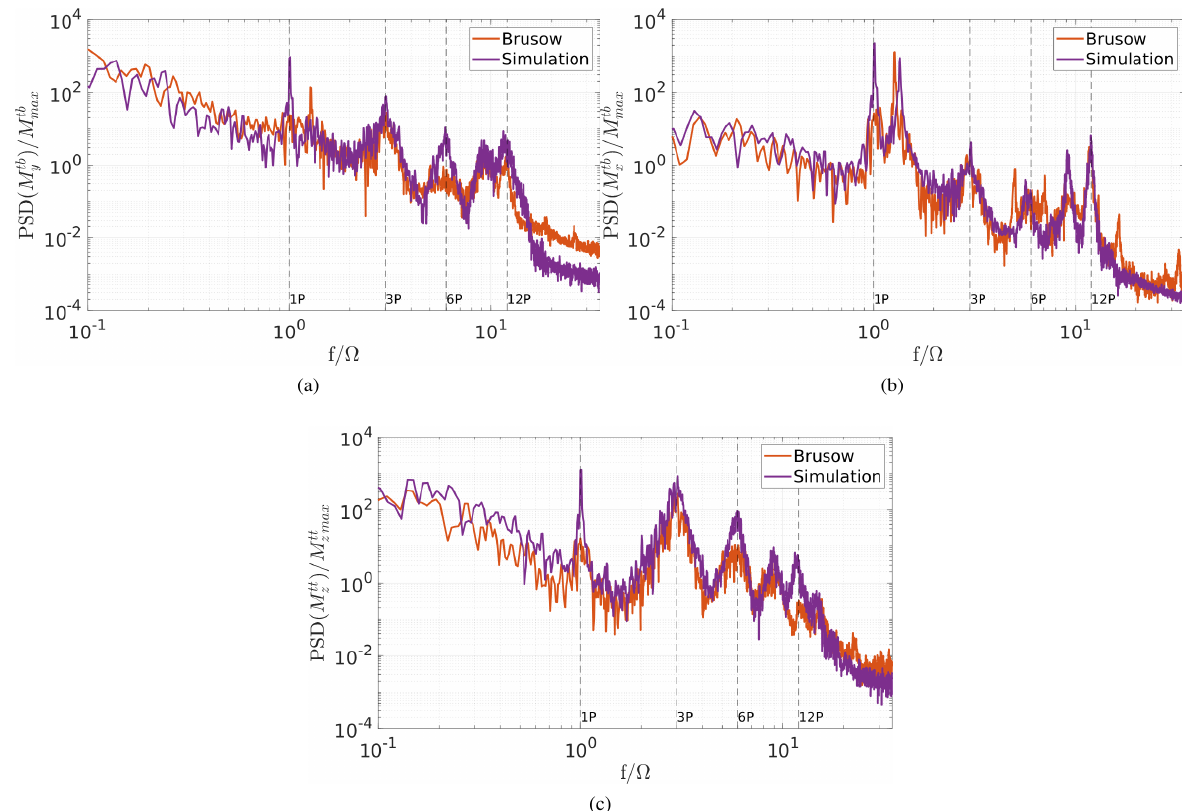
Figure 17. Spectrum of the tower moments: (a) the tower base bending in the fore-to-aft direction M tb y , (b) the tower base bending in the side-to-side direction M tb x and (c) the tower top torsion M tt z ; comparison of the measurement data to the simulation results (stable). The data are normalised by the maximum value of the tower base and tower top torsion moment, and the frequency is normalised by the rotor speed.